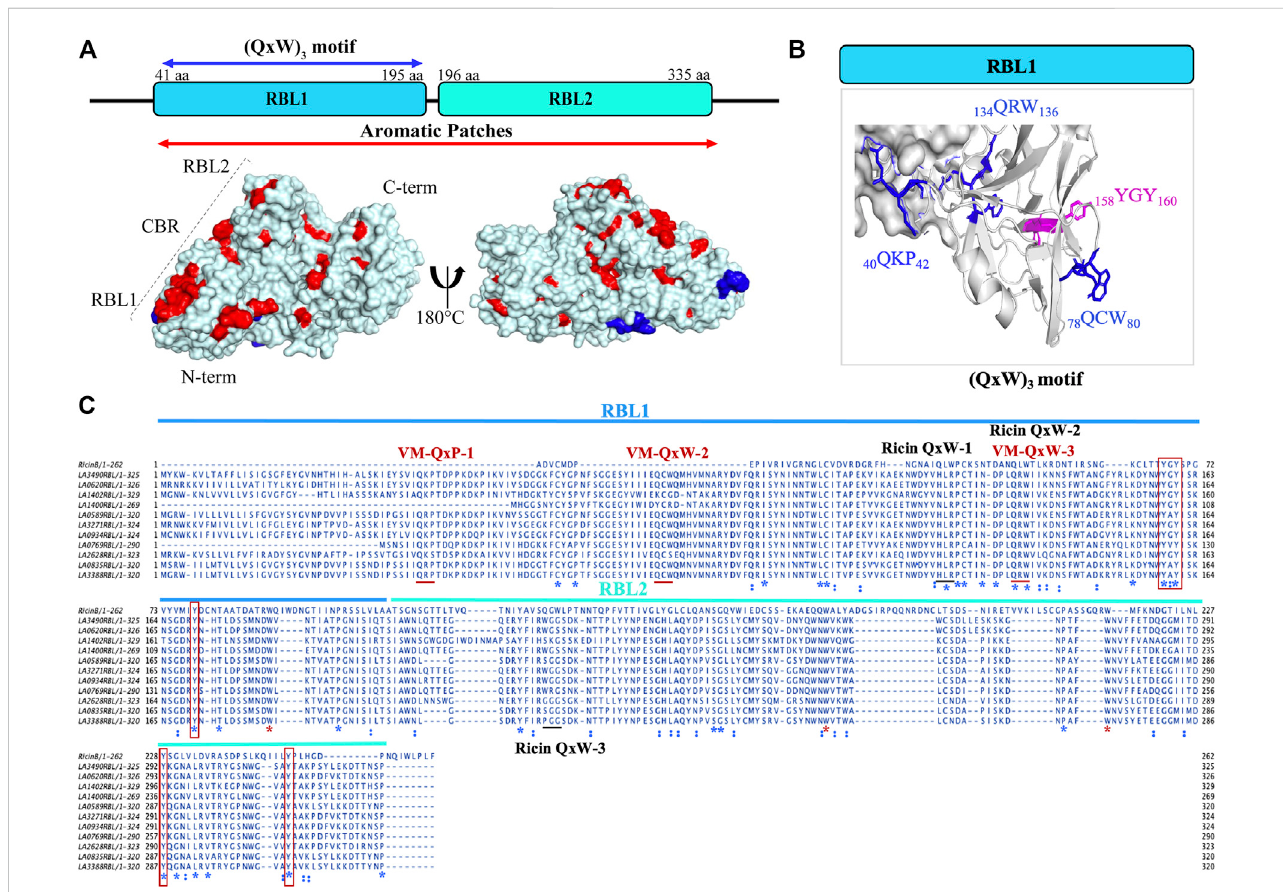
FIGURE 2 Structural and sequence representation of the (QxW) 3 motif in VM proteins in L. interrogans serovar Lai. (A) AlphaFold-generated high-resolution 3D structure of LA3490 VM protein shows amino acids which manifest as surface aromatic patches (red color: tyrosine, phenylalanine, and tryptophan). Blue color represents the (QxW) 3 motif within the N-terminal RBL1 domain. (B) RBL1 domain showing three conserved QxW motifs (blue color: 40 QKP 42